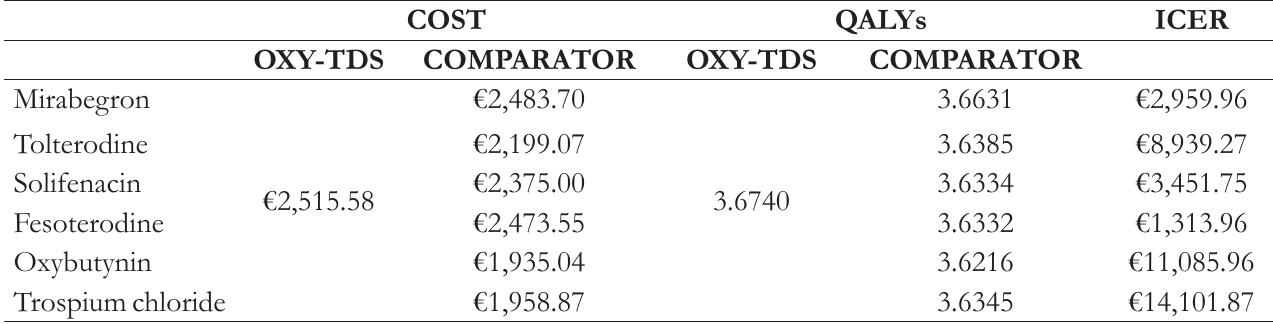
Table 4. Cost-effectiveness Analysis